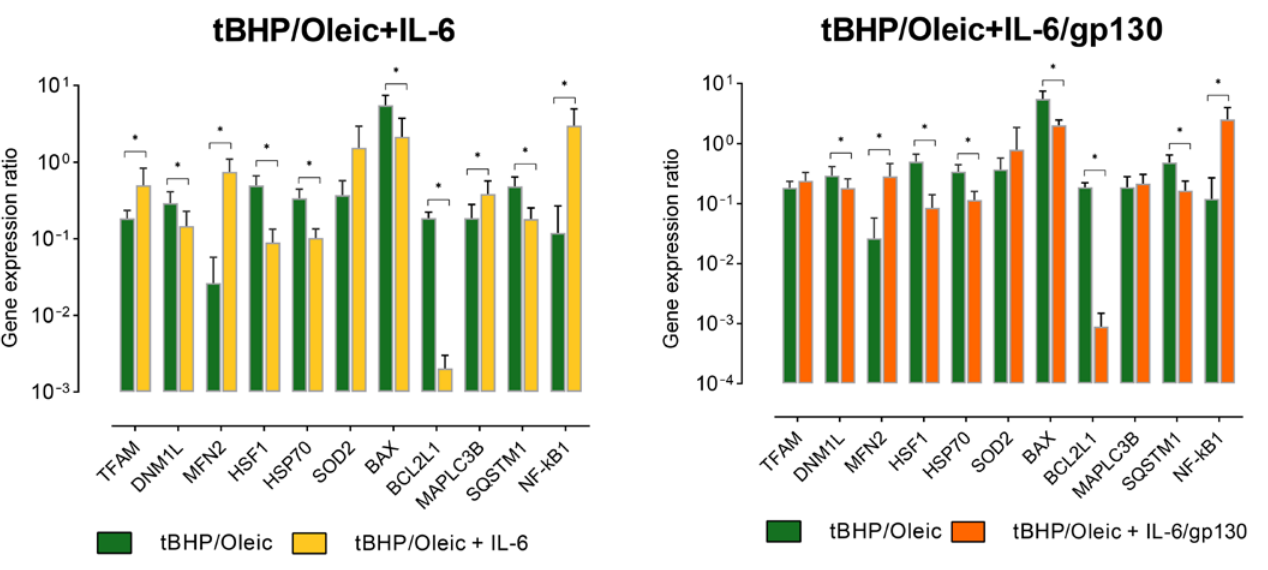
Figure 5. The level of gene expression in HepG2 cell models with the addition of IL-6 and IL-6/gp130; Mean ± SD; *— p < 0.05.